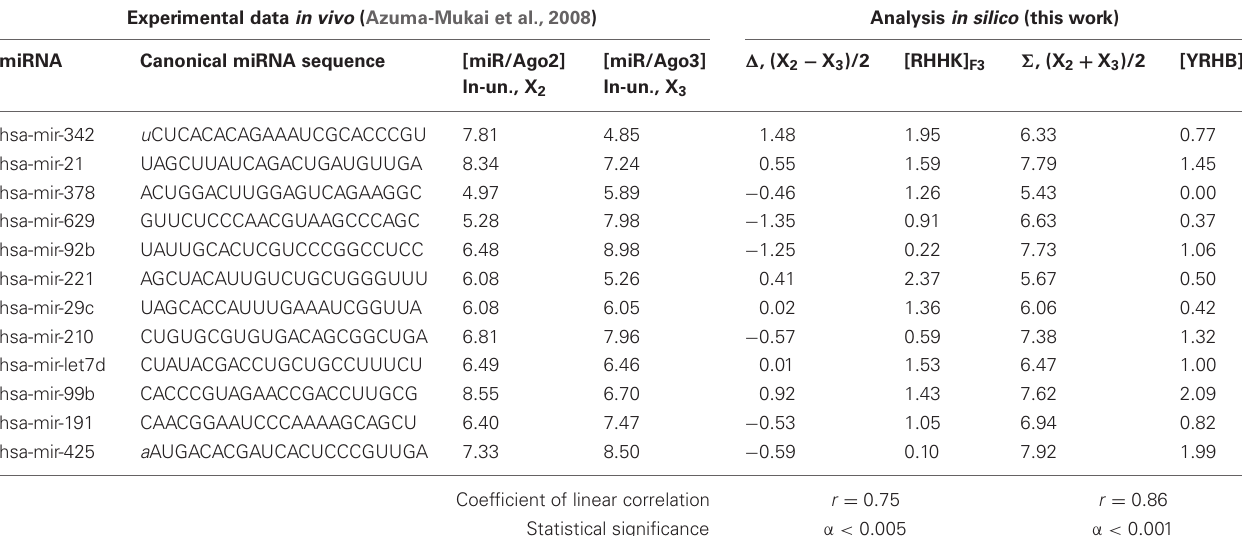
Table 2 | The training dataset (this work) of miRNA affinities for the human Ago2 and Ago3 proteins (Azuma-Mukai et al., 2008); 12 miRNA fragments each 22 nt in length are in